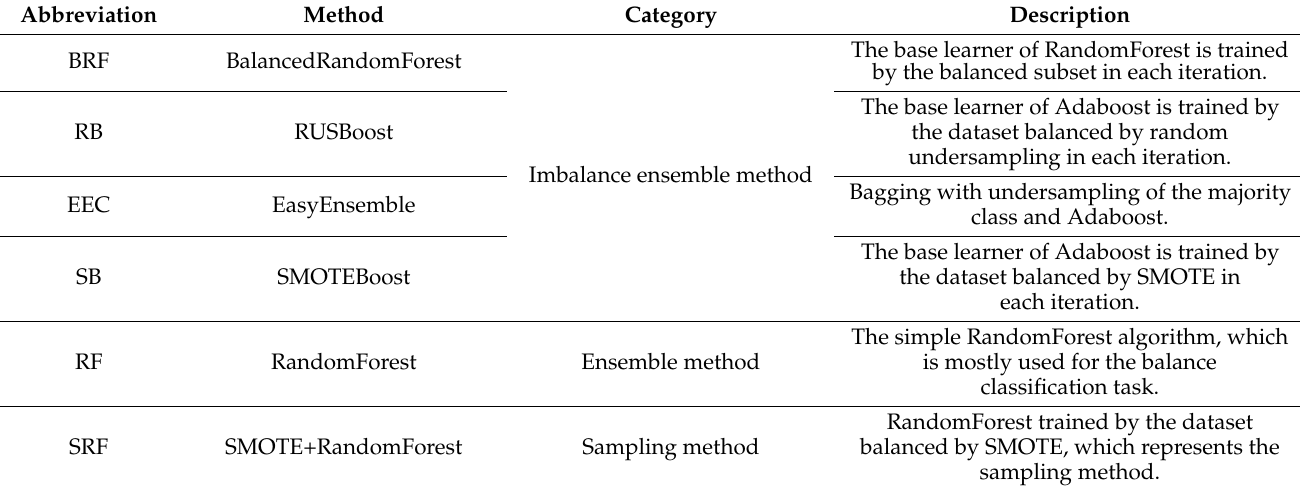
Table 7. Description of